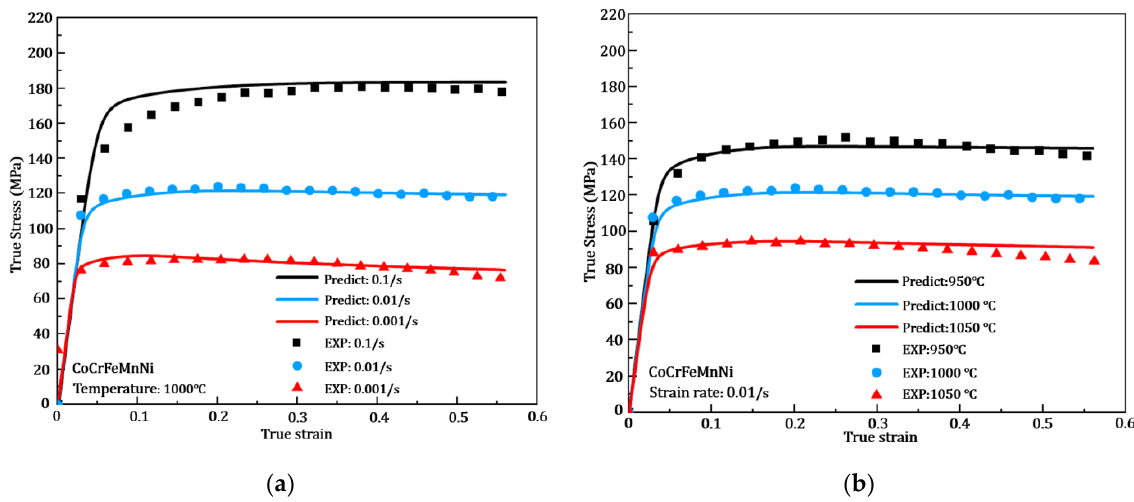
Figure 3. Comparisons of hot flow results under hot compression tests between experimentation and model computations results at various deformation conditions. ( a ) Strain rate effect at 1000 °C. ( b ) Temperature effect at 0.01/s.